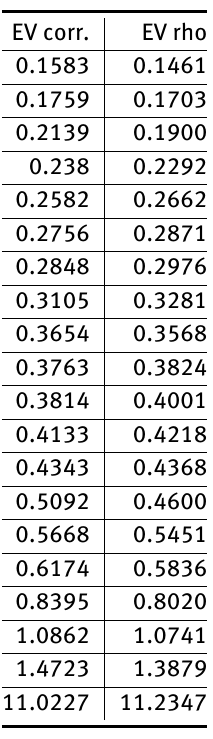
Table 6: Left: The eigenvalues of the correlation (EV corr.) and Spearman’s ρ (EV rho) matrices indicate that the two matrices are quite similar. Right: Annualized volatilities of the SMI return time